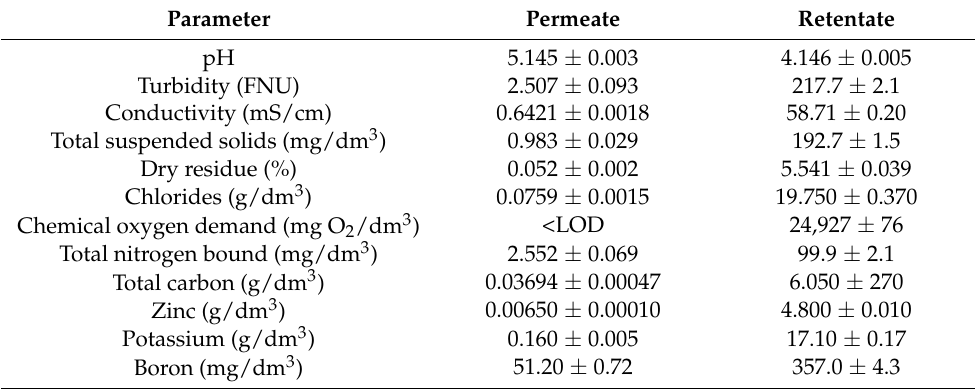
Table 3. Physical and chemical parameters of the permeate and retentate after RO.